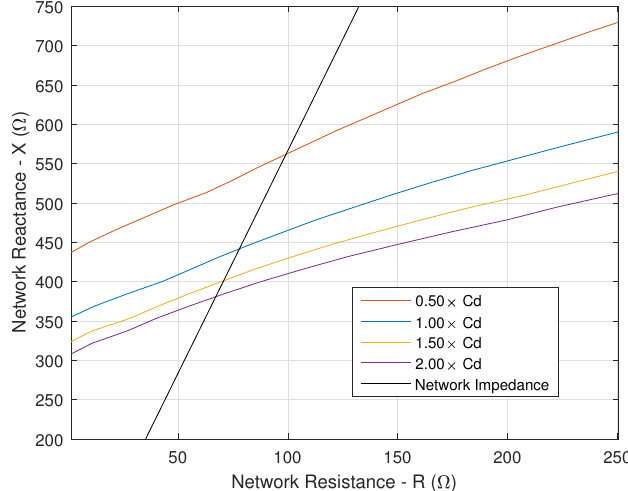
Figure 21. Stability limit curve of a traction chain in the network reactance ( X ) and resistant ( R ) complex plane. Variation of DC-link capacitance while keeping the voltage controller bandwidth at 8 Hz.